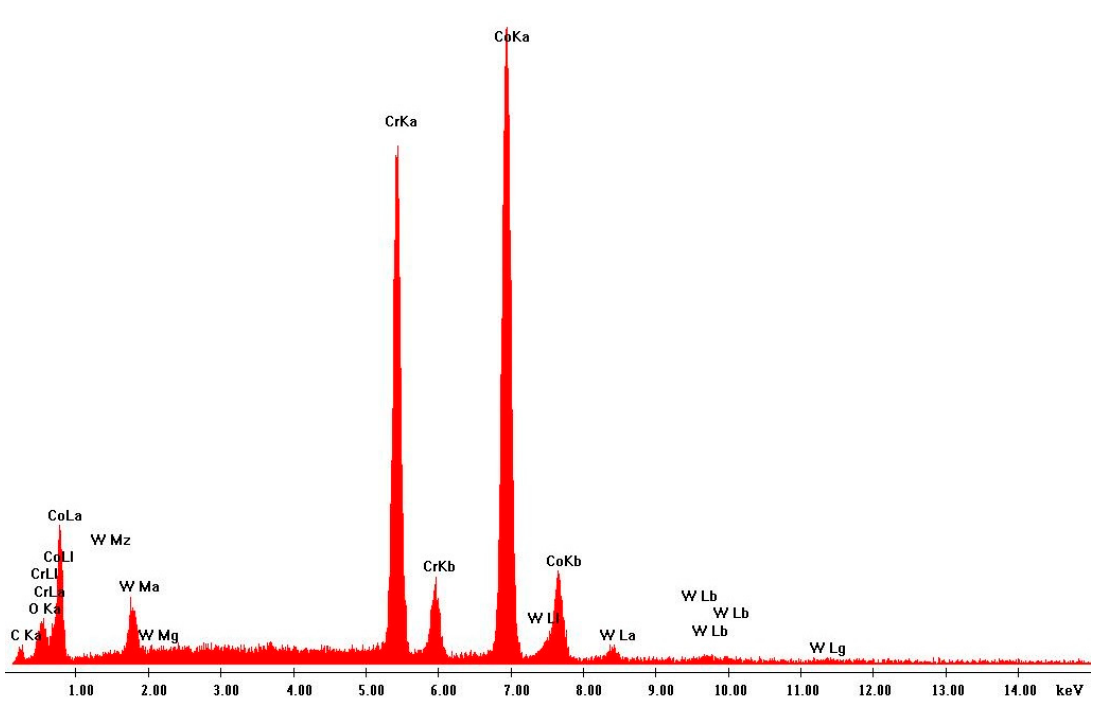
Figure 10. EDS analysis: sample collected during Trial 1 with the cobalt–chromium–silicon–carbon alloy.